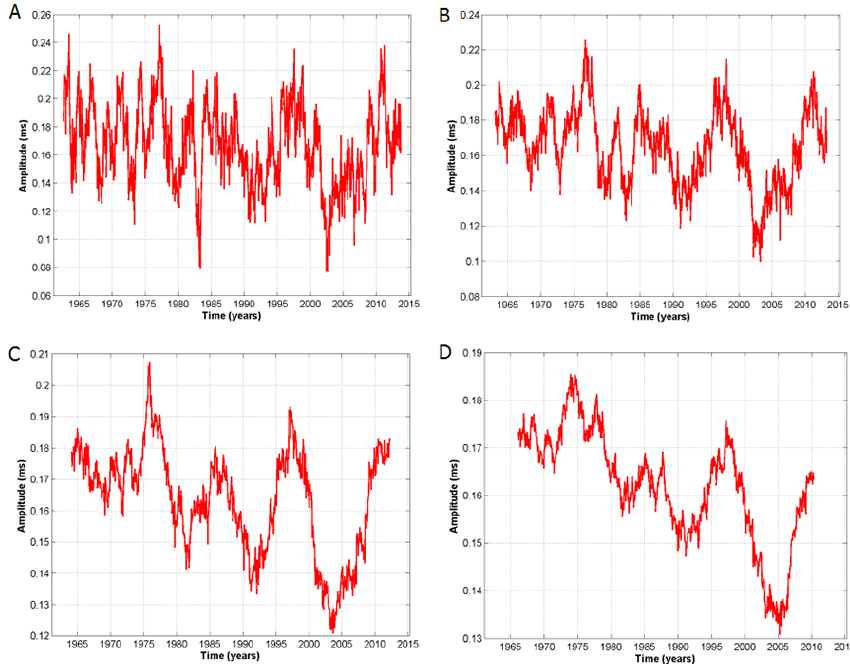
Figure 1. Amplitude of the 0.5-year FFT component of the LOD for different FFT sliding windows (2 τ ): 1 year (A) , 2 years (B) , 4 years (C) and 8 years (D)